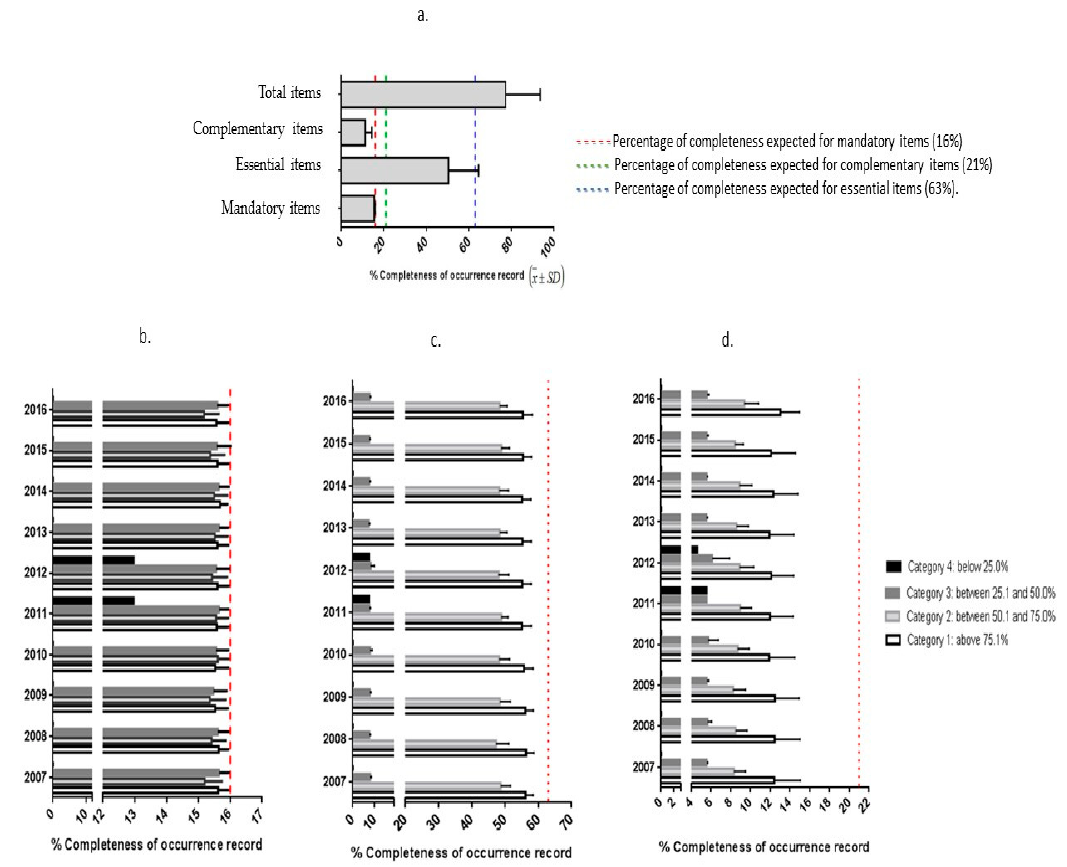
Figure 4. Percentage of database completeness according to the degree of recommendation of completing the variables (complementary, essential, and mandatory ( a )). Percentage of the mandatory ( b ), essential ( c ) and complementary ( d ) variables classified in Category 1, 2, 3 and 4 of completeness on National Epidemiological Surveillance System for Foodborne Diseases (VE-DTA).